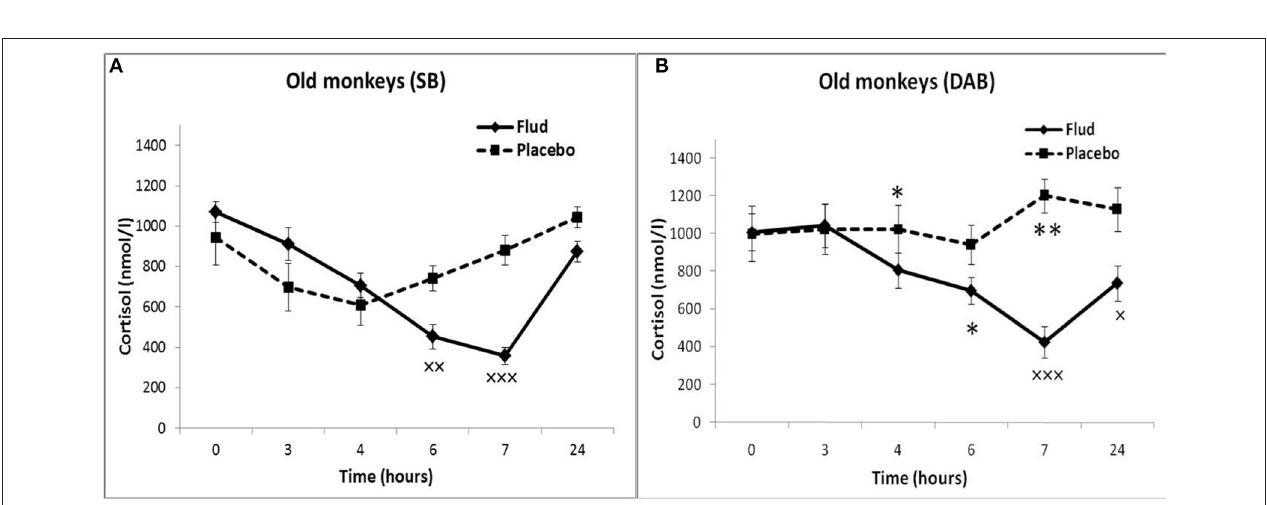
FIGURE 5 | Dynamics of CORT concentration in peripheral blood plasma of old female rhesus monkeys with SB (A) and DAB in response to administration of fludrocortisone and placebo (mean ± S.E.M). × p < 0.05, ×× p < 0.01, ××× p < 0.001 vs. placebo; (B) : * p < 0.05, ** p < 0.01 vs. relative values in animals with SB in response to FLUD or placebo administration (FLUD: F = 10.368; df = 1;14; p = 0.016; placebo: 4h: F = 7.231; df = 1;13; p = 0.022; 7 h: F = 15.546; df = 1;13; p =